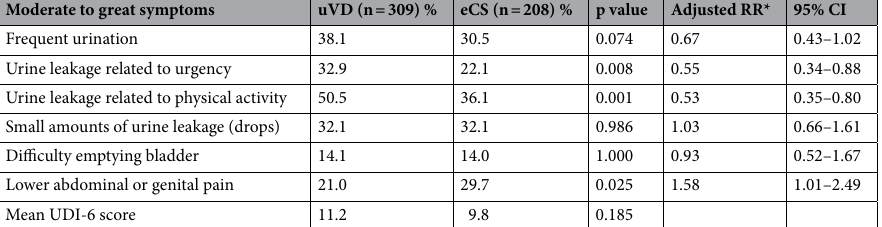
Table 2. Urinary distress inventory (UDI-6). uVD uncomplicated vaginal delivery, eCS elective cesarean section, RR relative risk, CI confidence intervals. *Adjusted relative risks (RR) of presenting symptoms after an uncomplicated vaginal delivery compared to an elective cesarean section. Relative risks were adjusted for all socio-demographic and physical variables of Table 1.